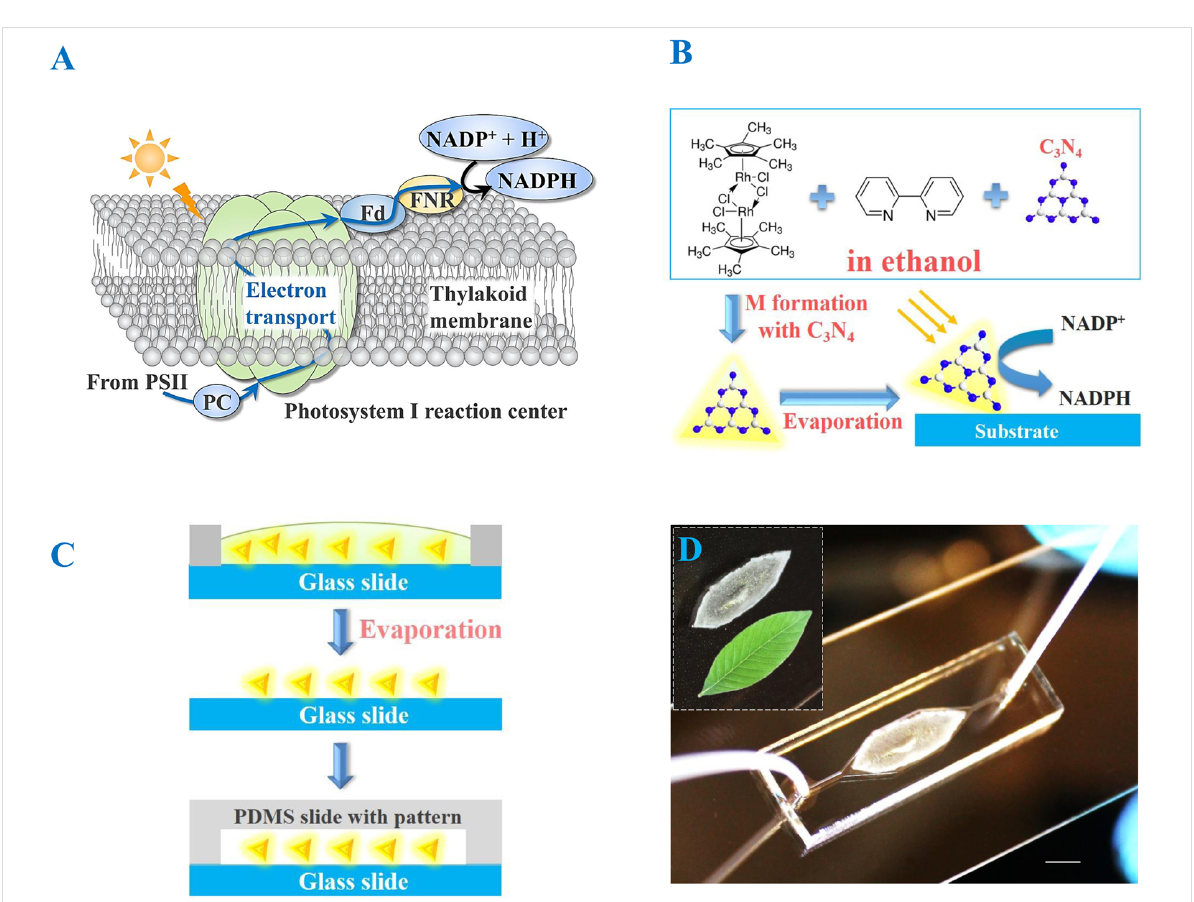
Figure 9: Microfluidic chip based artificial photosystem I. (A) Schematic illustration of the PS I reaction center. (B) One-step fabrication process of the immobilized artificial PS I (IAPSI) in the form of the g-C 3 N 4 -M film. (C) Simple procedures to fabricate the IAPSI microreactor. (D) Photograph of the as-fabricated IAPSI microreactor, in which the inset presents the leaf-like shape of g-C 3 N 4 -M. The scale bar is 2 mm. Adapted from [89], copyright 2016 The Royal Society of